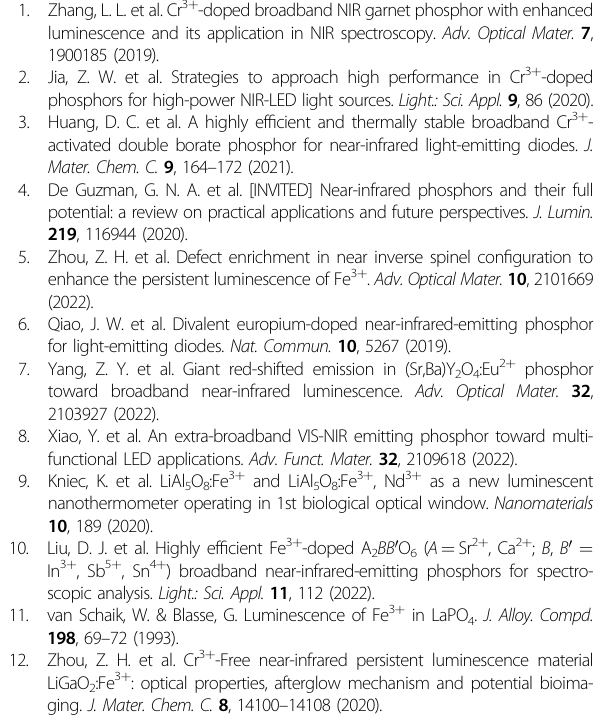
Fig. 1 Design principle and application of environmentally friendly NIR phosphor. Schematic view of Fe 3 + -activated near- infrared-emitting phosphors for NIR spectroscopic